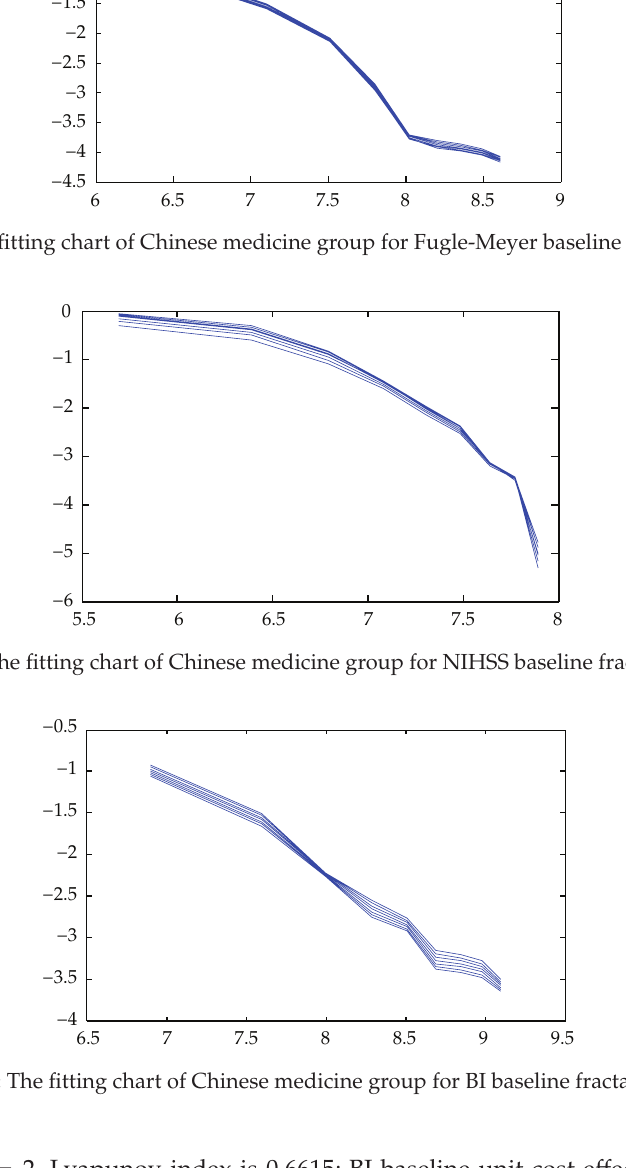
dimension for m (cid:8) 2, Lyapunov index is 0.6615; BI baseline unit cost e ff ectiveness on time series embedding dimension for m (cid:8) 4, Lyapunov index is